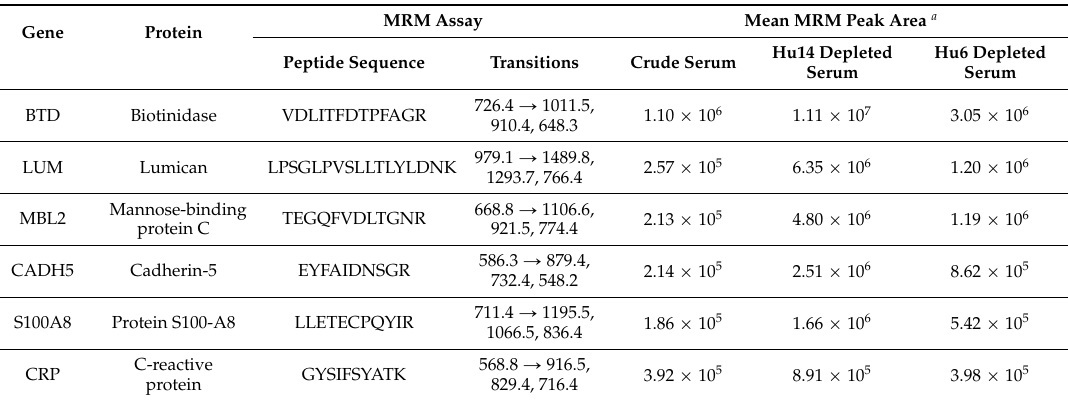
Table 2. List of targeted proteins and corresponding peptides and transitions for comparison of different immunodepletion columns for removal of high abundant serum proteins.